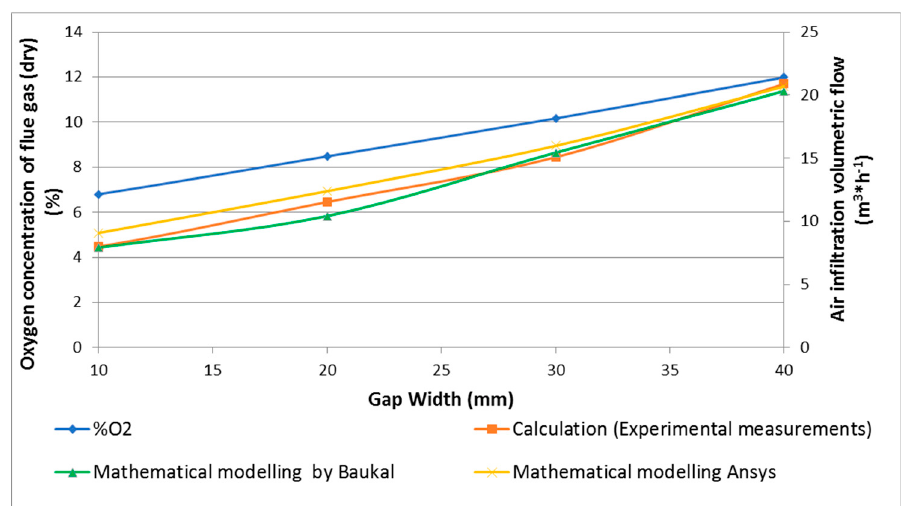
Figure 15. Comparison of air infiltration volumetric flow: Calculated using experimental data (orange); obtained from modeling in ANSYS (yellow); and calculated using the approach proposed by Baukal [35] (green).